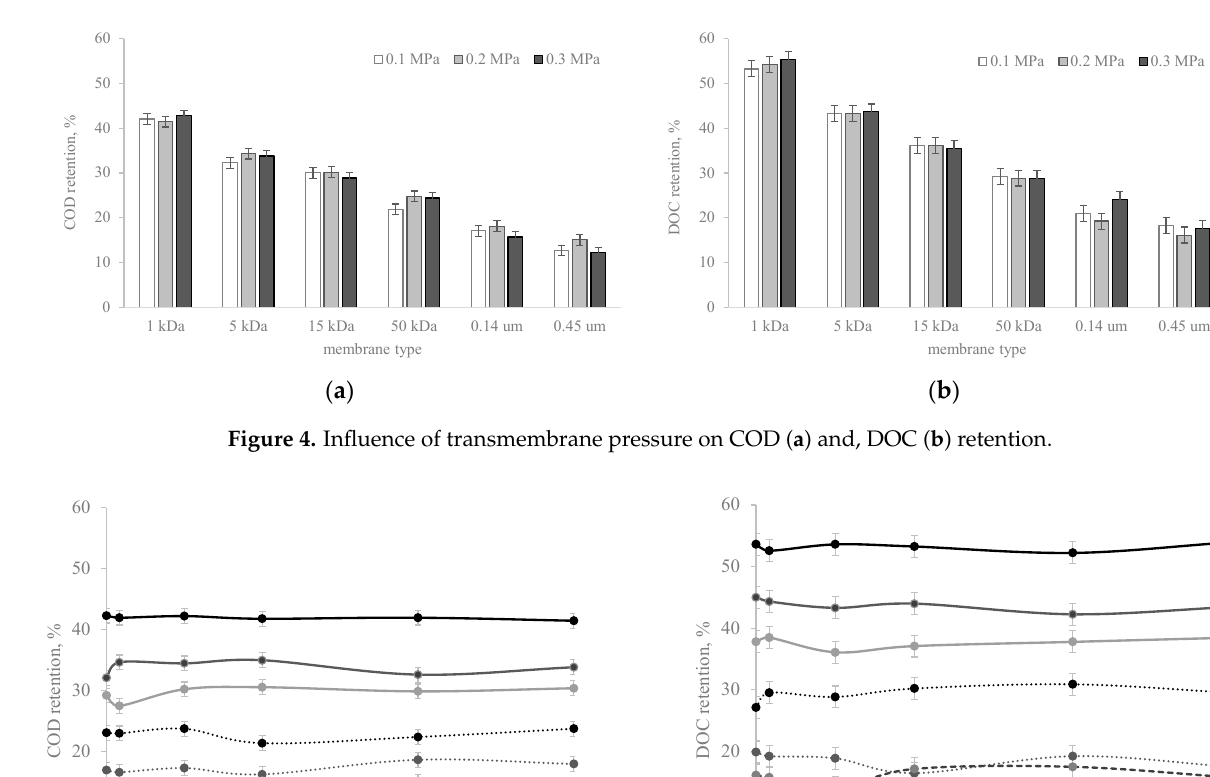
Figure 4. Influence of transmembrane pressure on COD ( a ) and, DOC ( b ) retention.